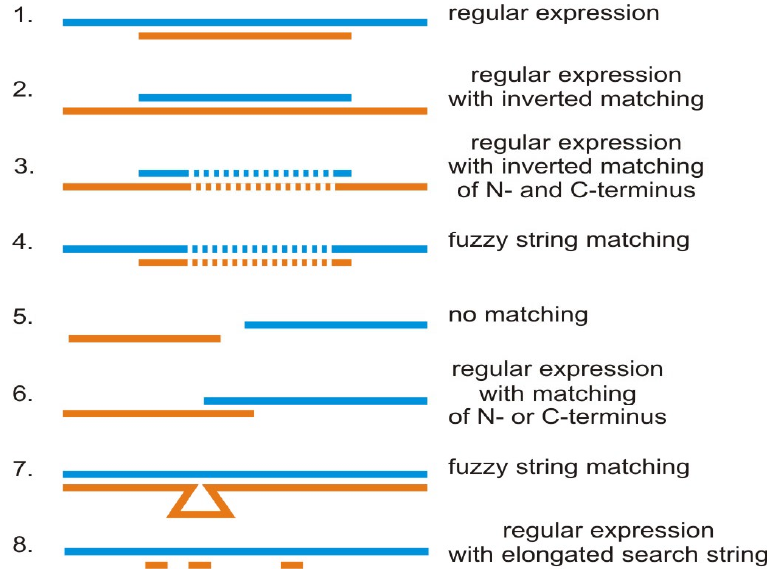
Fig. 1 Possible relation between SWISS-PROT sequence annotations (orange lines) and chains of PDB entries (blue lines) and the matching method. Mismatches are indicated as dotted lines. 1.: The feature sequence lies completely in the chain sequence and matches exactly to it. 2.: The feature sequence is longer than the chain, but the chain matches exactly to it. 3.: As 2 but the sequences differ. 4.: Both sequences differ. 5.: The feature sequence lies outside the PDB sequence. 6.: Sequences overlap to some extend. 7.: The chain is deleted within the sequence. 8.: The feature sequence matches at multiple positions to the chain